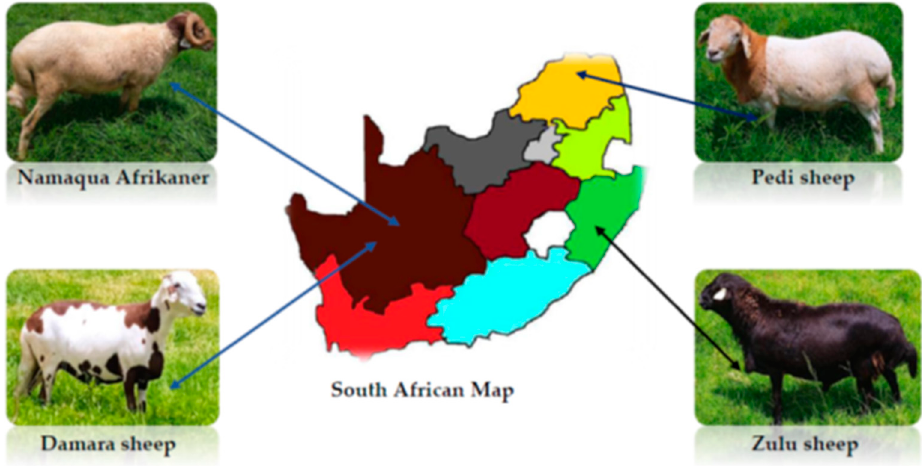
Figure 1. South African indigenous sheep and their geographical location. Table 1. Role of South African indigenous breeds in developing composite breeds . Locally Developed Use of the Breed Indigenous/Composi Breed (Composite Exotic Breed Used Breed Developer Reference Developed te Breed Used Breed)